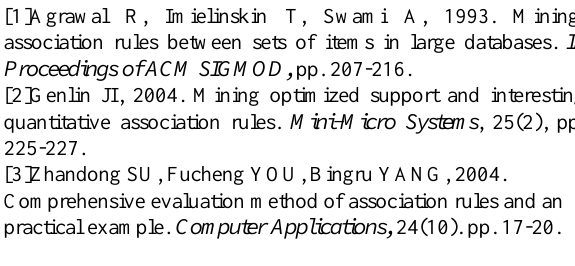
Table 5.The rules in spatial knowledge base